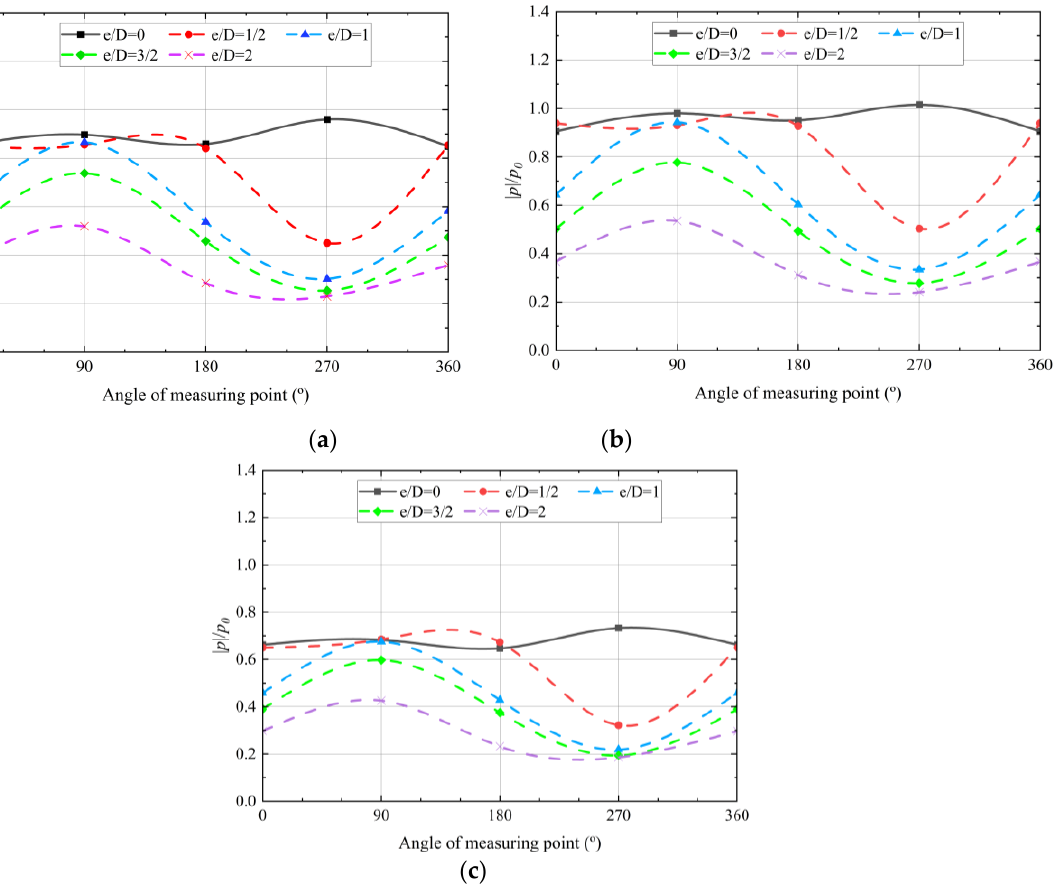
Figure 5. Variation of the dimensionless pore pressure amplitude around the pipeline with different backfill depths when 𝑈 𝑐 = 0 m/s and ± 0.3 m/s. ( a ) 𝑈 𝑐 = 0 m/s; ( b ) 𝑈 𝑐 = 0.3 m/s; ( c ) 𝑈 𝑐 = − 0.3